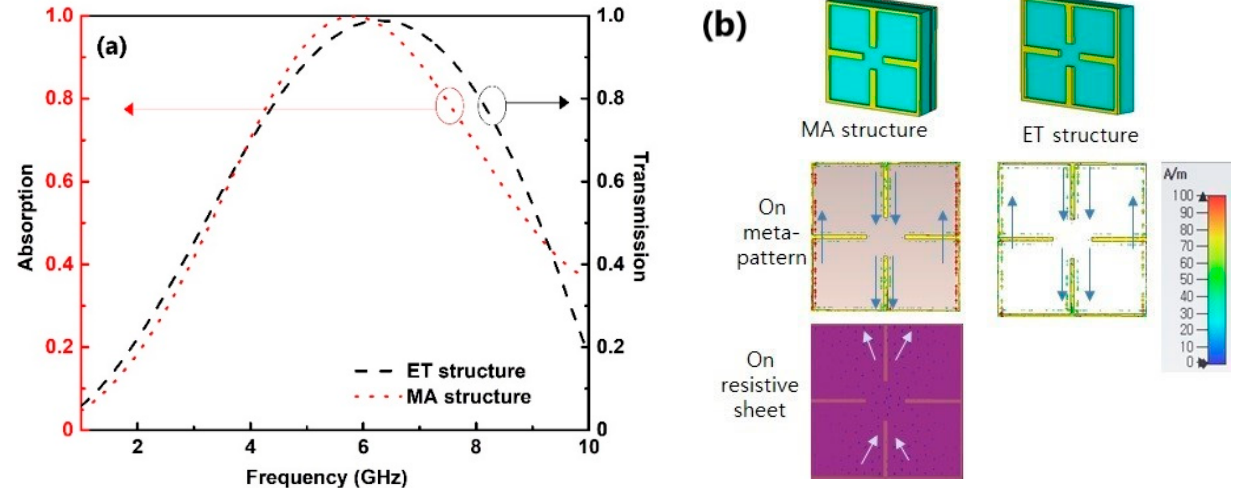
Figure 4. ( a ) Absorption and transmission spectra of the ET and MA structures. ( b ) Distributions of the surface current (in arrow) and magnetic field (in dot) in the ET and MA structures.